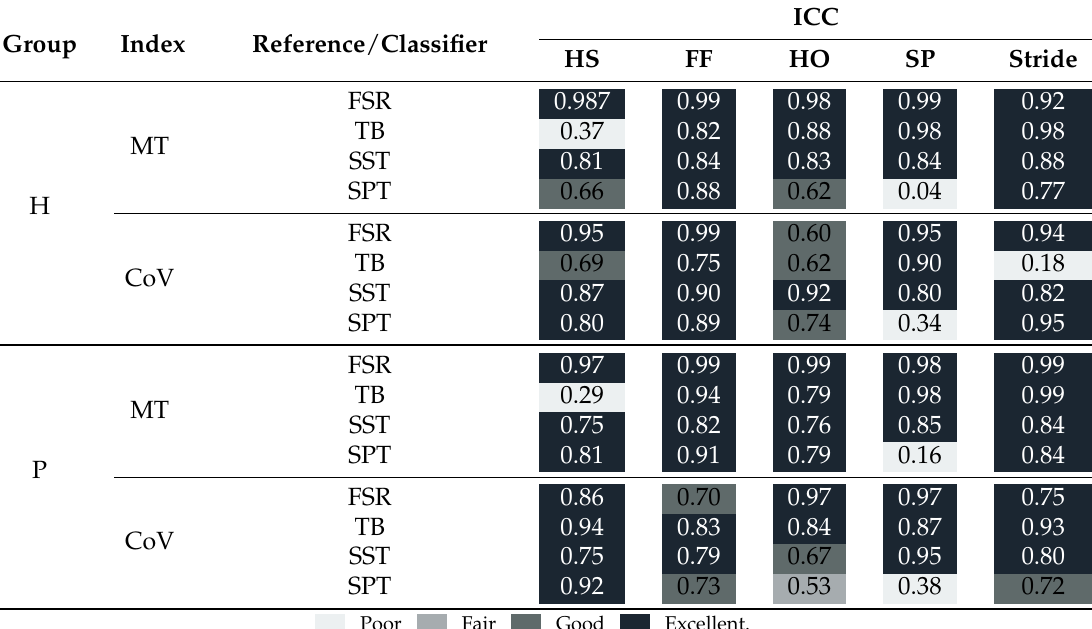
Table 4. Values of Intra-class Correlation Coefficients (ICC) for Mean Time (MT) and Coefficient of Variation (CoV) evaluated for stride and each detected gait phase by FSR reference system and